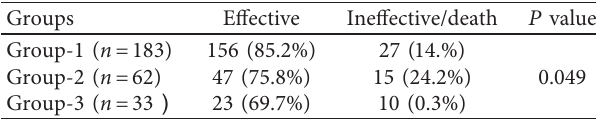
Table 8: Overall effectiveness difference between the 3 groups (7 days after stopping treatment).